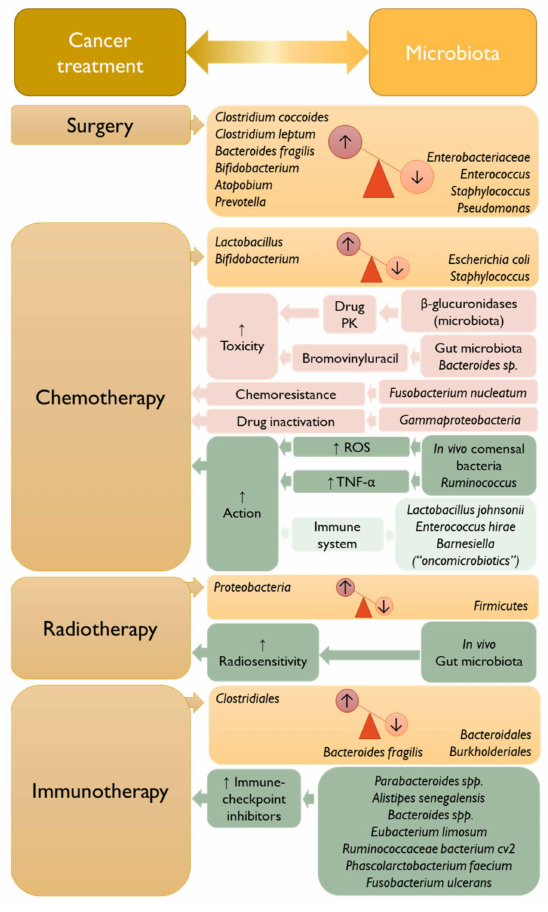
Figure 4. Overview of the common anticancer treatments and their influence on the microbiome and vice-versa [110]. PK, pharmacokinetics; ROS, reactive oxygen species; TNF- α , tumor necrosis